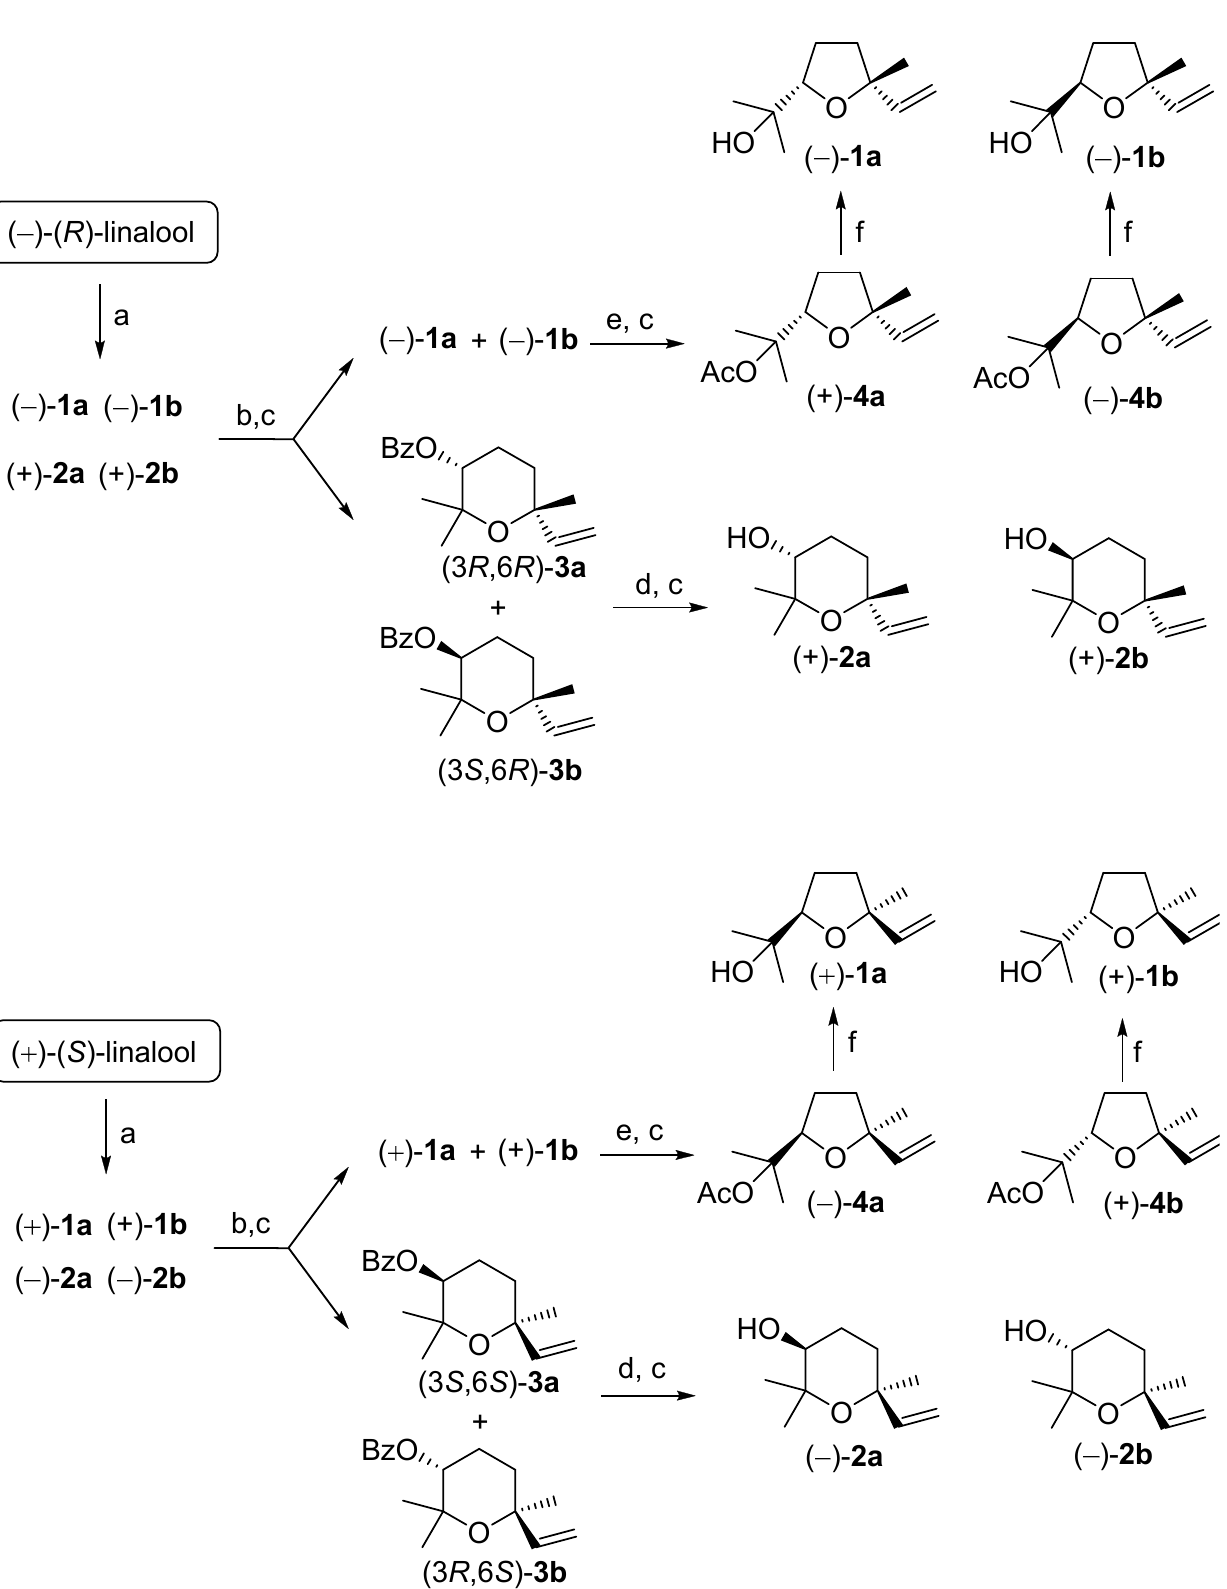
Scheme 1. Experimental procedure for the preparation of all the isomeric forms of linalool oxide starting from ( R )- linalool and ( S )-linalool. Reagents and conditions: ( a ) m CPBA, CH 2 Cl 2 , 0 ◦ C, PTSA cat.; ( b ) BzCl, Py, CH 2 Cl 2 , 0 ◦ C; ( c ) chromatographic separation; ( d ) NaOH/MeOH, reflux, 3 h; ( e ) NaOAc, Ac 2 O, reflux, 3 h; ( f ) LiAlH 4 , dry Et 2 O, r.t. 1